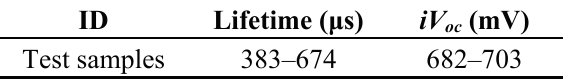
Figure 4. Structure of the test samples for the UTSi solar cells based on epi on FZ wafer. Table 5. Lifetime and iV oc of epi on FZ wafer test samples.